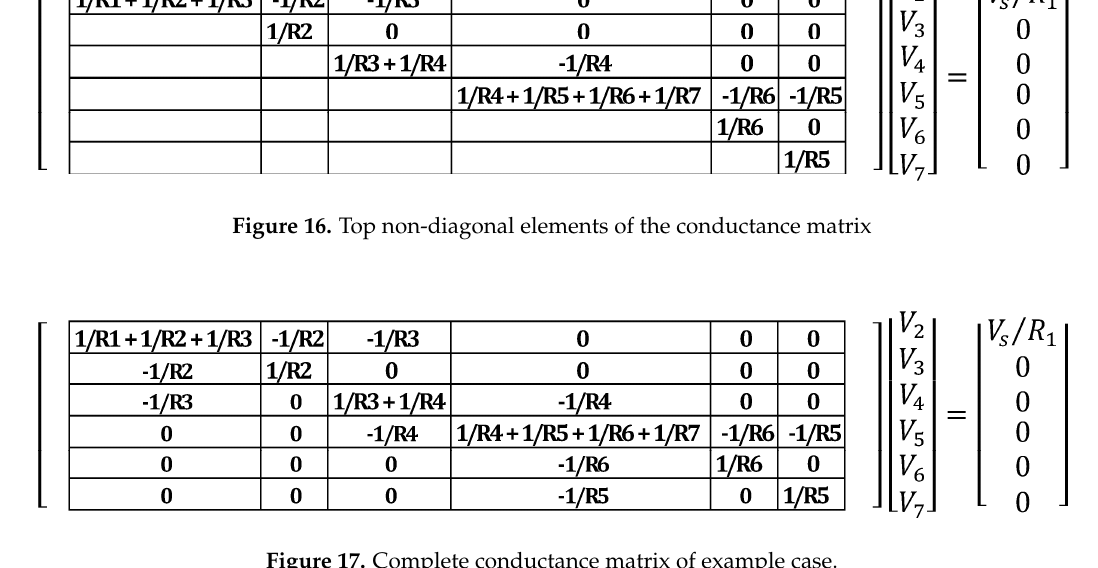
Figure 17. Complete conductance matrix of example case.